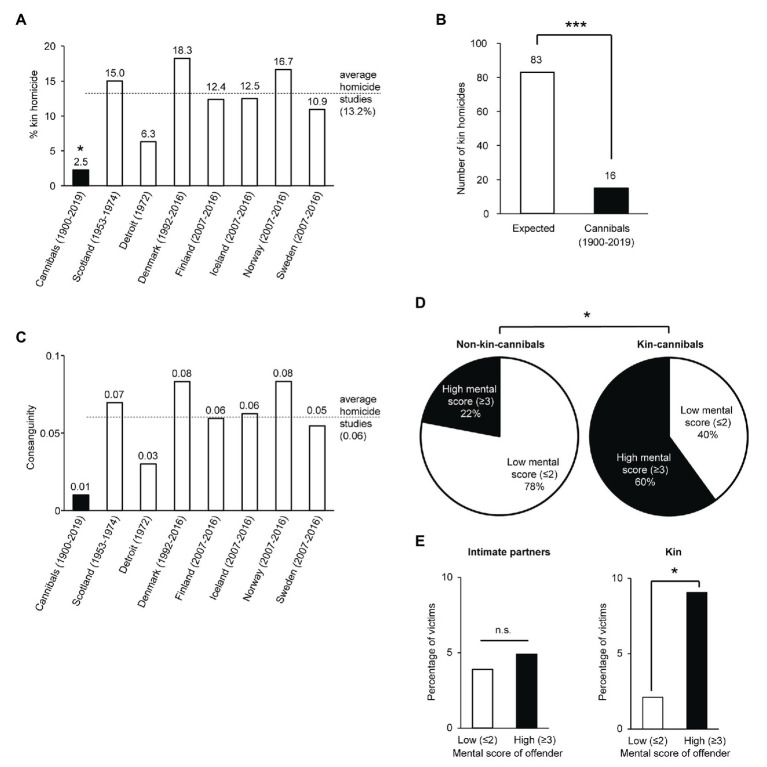
Kin-avoidance in cannibalistic and other homicides. (A) Fraction of kin homicides in cannibalistic offenses (this study) and other homicide studies (Gillies, 1976; Daly and Wilson, 1982; Lehti et al., 2019; Thomsen et al., 2019). The fraction of kin homicides is different between cannibals and conventional homicides in other countries [X
2(7) = 16.8, p = 0.02, post-hoc pairwise comparison X
2 = 8.7, p = 0.02 for cannibalistic homicides, others n.s., fdr adjusted]. (B) Expected and observed number of cannibalistic homicides on kin, based on the average percentages from other homicide studies in A and total number of homicides in this study. The observed number of kin victims in cannibalistic cases is lower than expected [X
2(1) = 62.3, p < 0.001]. (C) Consanguinity in cannibalistic offenses (this study) and other homicide studies (Gillies, 1976; Daly and Wilson, 1982; Lehti et al., 2019; Thomsen et al., 2019). (D) Mental health scores for non-kin (left) and kin-cannibals (right). Scores were computed by adding +1 for each: prior-to-offense psychiatric institutionalization, report of auditory hallucinations, insanity (reduced responsibility) plea, insanity (reduced responsibility) verdict. Offenders unfit for trial, because of mental health problems: +2. Contradictory or unclear reports were scored as 0.5 points. Low mental scores were considered 2 points or less, high mental scores were considered a score of 3 or 4. Kin cannibals had a high mental score more often than non-kin cannibals [X
2(1) = 4.5, p = 0.034]. (E) The percentage of victims which were intimate partners or which were kin for offenders with a low mental health score (≤2) and offenders with a high mental health score (≥3). Mean percentage of intimate partner victims for offenders with low mental health score: 3.9%, for offenders with high mental health score: 4.9%, X
2(1) = 0.009, p = 0.92. Mean percentage of kin victims for offenders with low mental health score: 2.1%, for offenders with high mental health score: 9.0%, [X
2(1) = 6.0, p = 0.01].